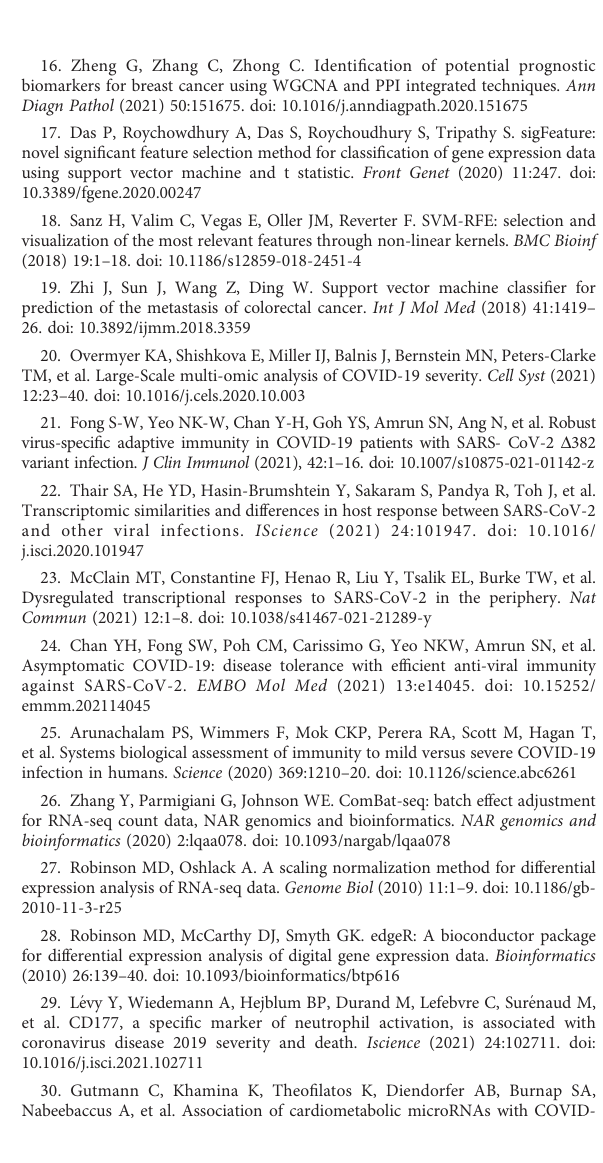
SUPPLEMENTARY TABLE 6 List of enriched pathways by the DE_Smodules of cyan and lightyellow. SUPPLEMENTARY TABLE 7 List of genes in each identi fi ed module from the analysis of severe and non-severe COVID-19. SUPPLEMENTARY TABLE 8 The results of module preservation analysis for the analysis of severe vs. non-severe COVID-19 subjects.